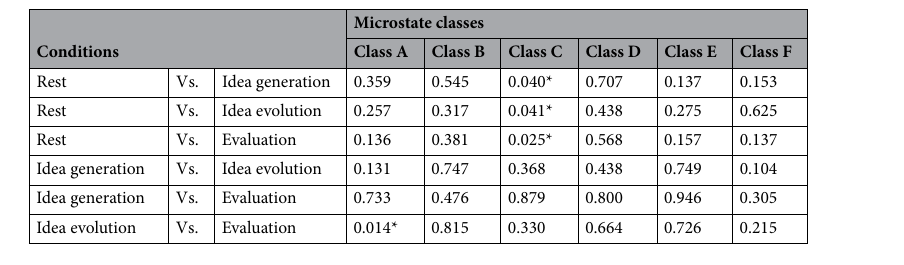
Table 2. Paired TANOVA p-values for microstate topography between conditions. * ρ < 0.050 , ** ρ < 0.010 , *** ρ <